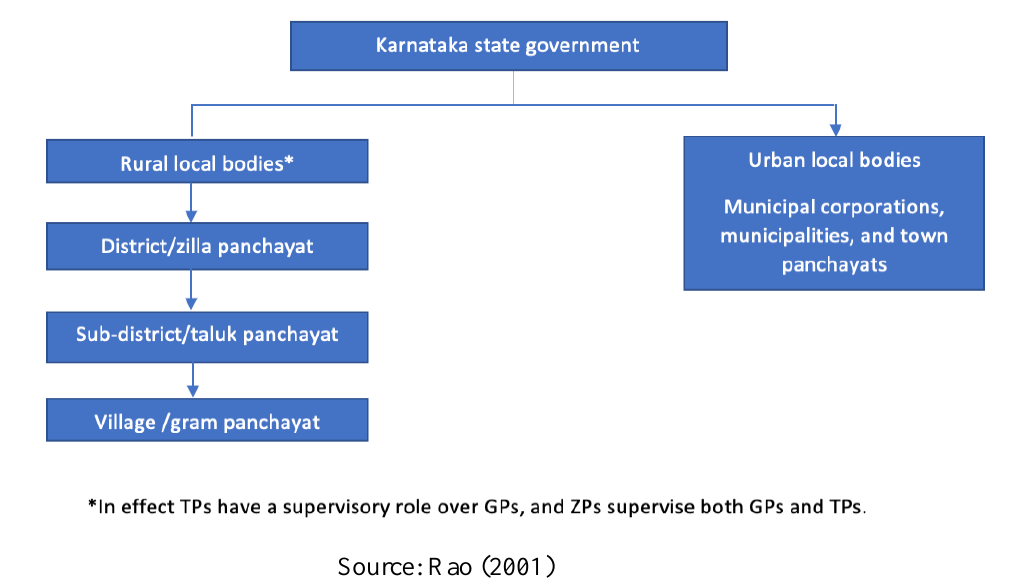
Figure 1: Structure of multi-level government in Karnataka